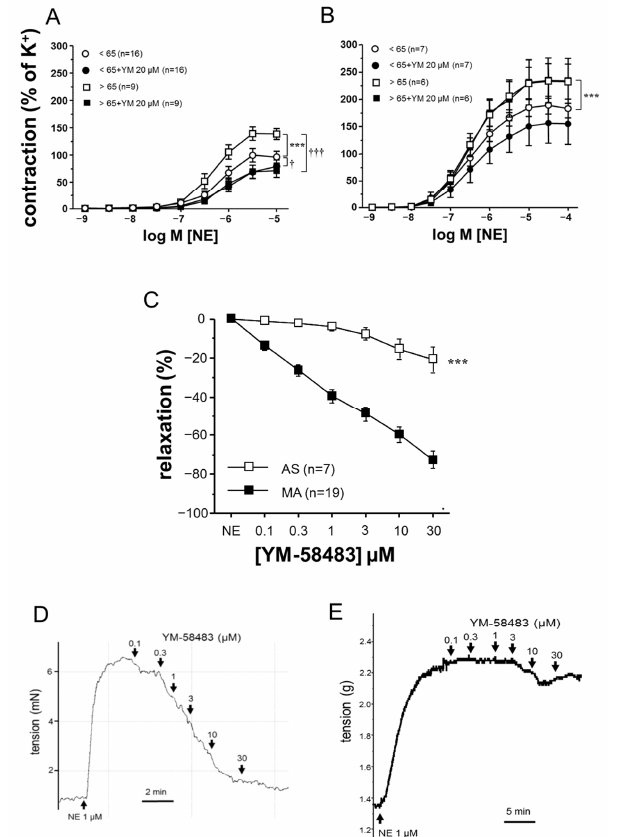
Figure 1. Aging-related hypercontractility to adrenergic stimulation in the human mesenteric artery is reversed by Orai channel inhibition. Effects of Orai channel inhibition with YM-58483 (20 μ M) on norepinephrine (NE)-induced contraction in human mesenteric arteries (MA ( A )) and human aortic strips (AS ( B )) obtained from organ donors <65-years and >65-years old. Data are expressed as mean ± SEM of the percentage of contraction induced by 125 mM K + before the addition of YM-58483 or the vehicle (0.2% DMSO). n indicates the number of subjects. *** p < 0.001 vs. <65-years old; † p < 0.05, ††† p < 0.001 vs. respective responses without YM-58483 by two-factor ANOVA followed by Bonferroni’s correction. ( C ) Complete concentration–response curves of YM-58483-induced relaxation in human AS and MA precontracted with NE obtained from organ donors. Data are expressed as mentioned above. *** p < 0.001 vs. MA. Representative tracings of these responses in MA and AS are shown in ( D , E ), respectively.